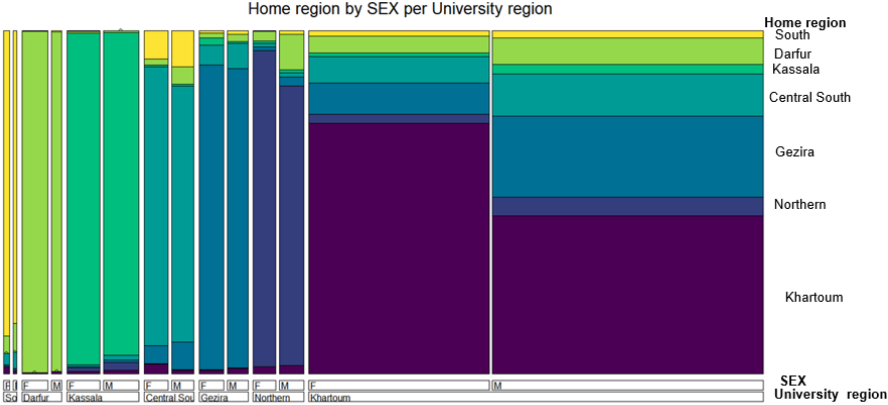
Figure 20. Double-decker plot showing the regional diversity of universities in different regions for 2016–2017 incoming male and female diploma students.